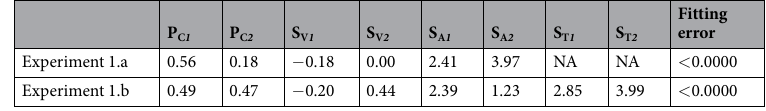
Table 1. Fitted parameters in experiments 1.a and